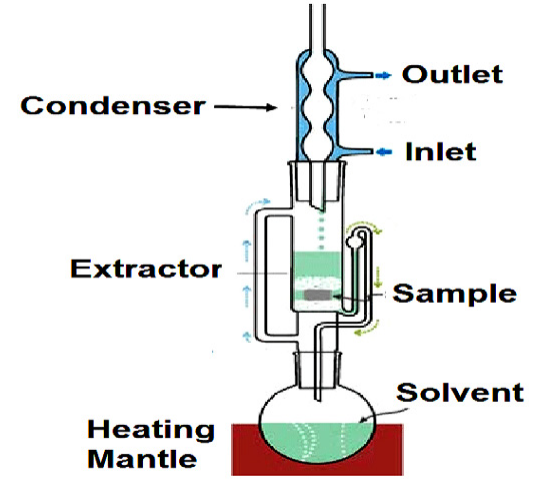
Fig. 1. Schematic representation of Soxhlet extraction apparatus